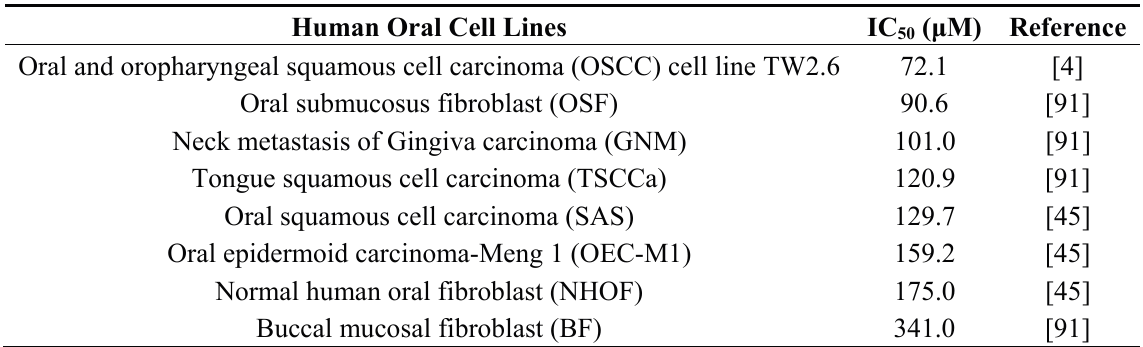
Table 1. IC 50 of CAPE for causing growth inhibition in non-malignant and cancerous human oral cell